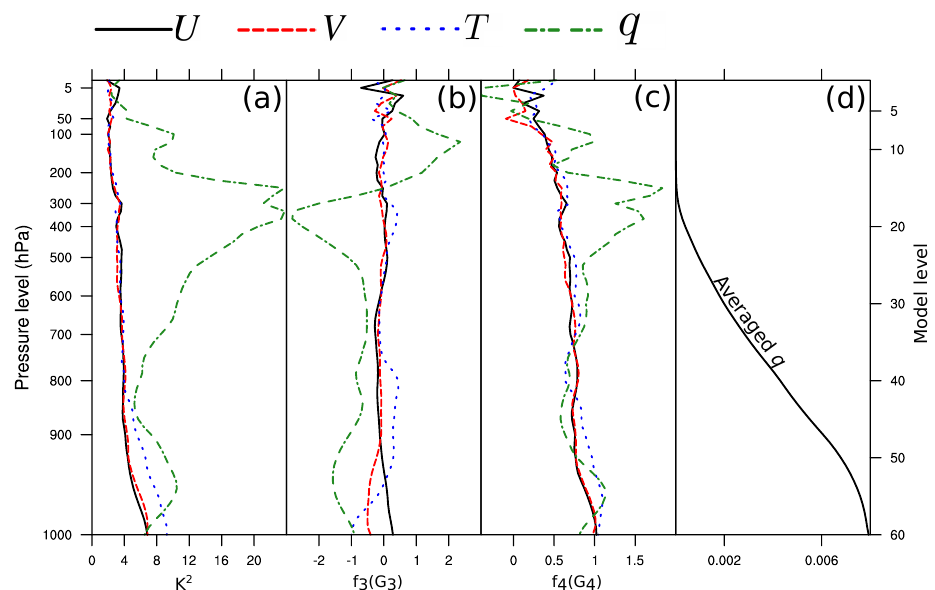
Figure 3. Vertical profiles of (a) K 2 , (b) transformed skewness f 3 (G 3 ) , (c) transformed kurtosis f 4 (G 4 ) , and (d) q (kgkg − 1 ) for one member of the ensemble. For each level, values are averaged over the horizontal domain. Profiles are computed from the 90-member ensemble of AROME-France 3h forecasts valid at 03:00UTC on 4 November 2011. Profiles in (a) , (b) , and (c) are given for four model variables: U , V , T , and q .